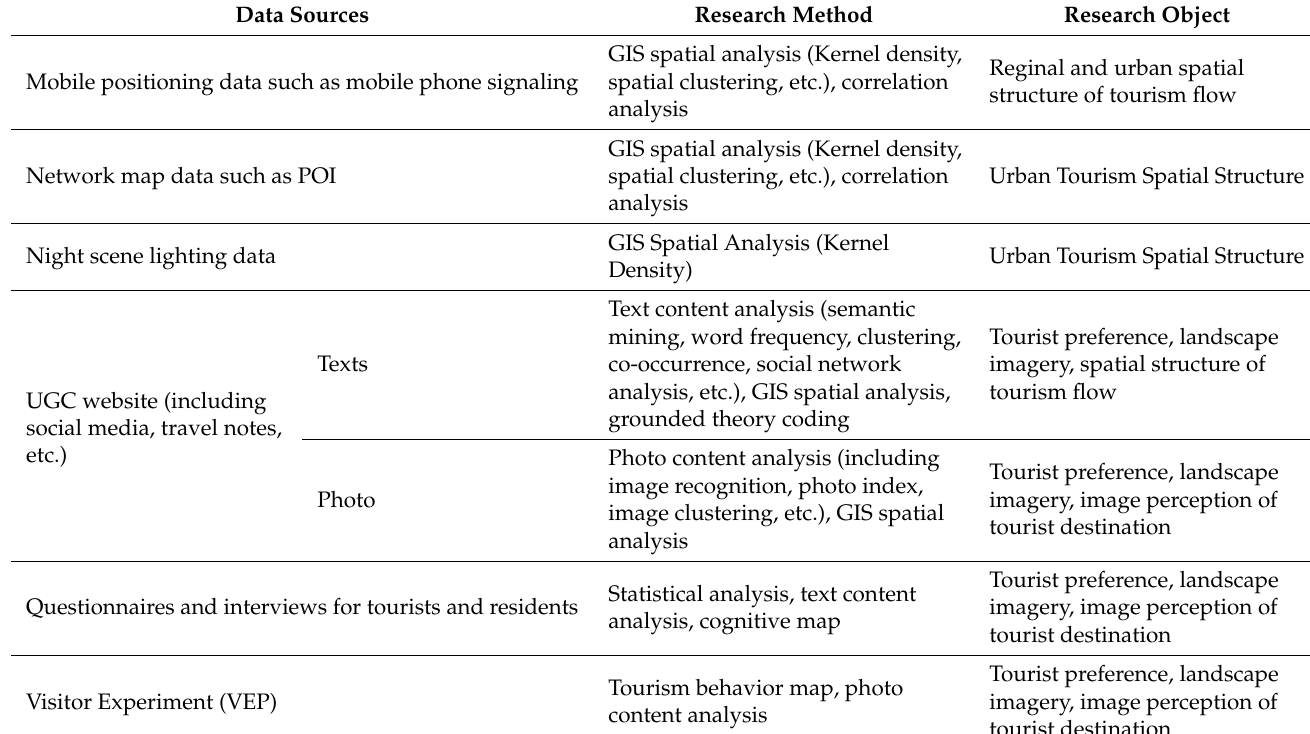
Table 1. Research method and object of tourist cognition (source: